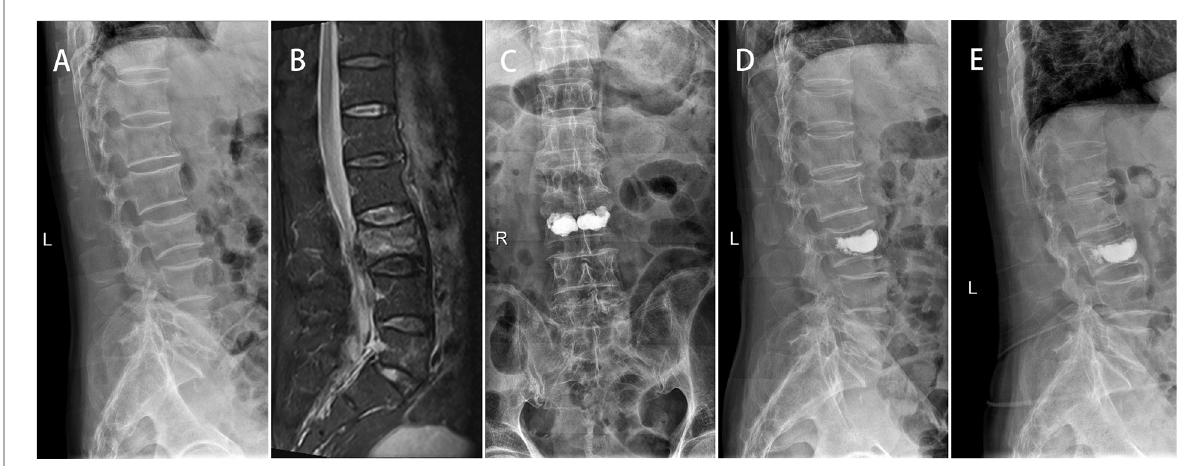
FIGURE 2 A 75-year-old male patient with L3 OVCF developed painless recompression of the operative vertebra. X -ray showed a wedge-shaped change of L3 ( A ). MR showed a fresh compression fracture of L3 ( B ). After PKP surgery, x -ray showed that the cement was densely distributed on both sides of the vertebra ( C ) and the height of L3 vertebral body was improved compared with that before operation ( D ). At 1-year follow-up, x -ray showed that L3 vertebral body recompressed and kyphosis was aggravated ( E